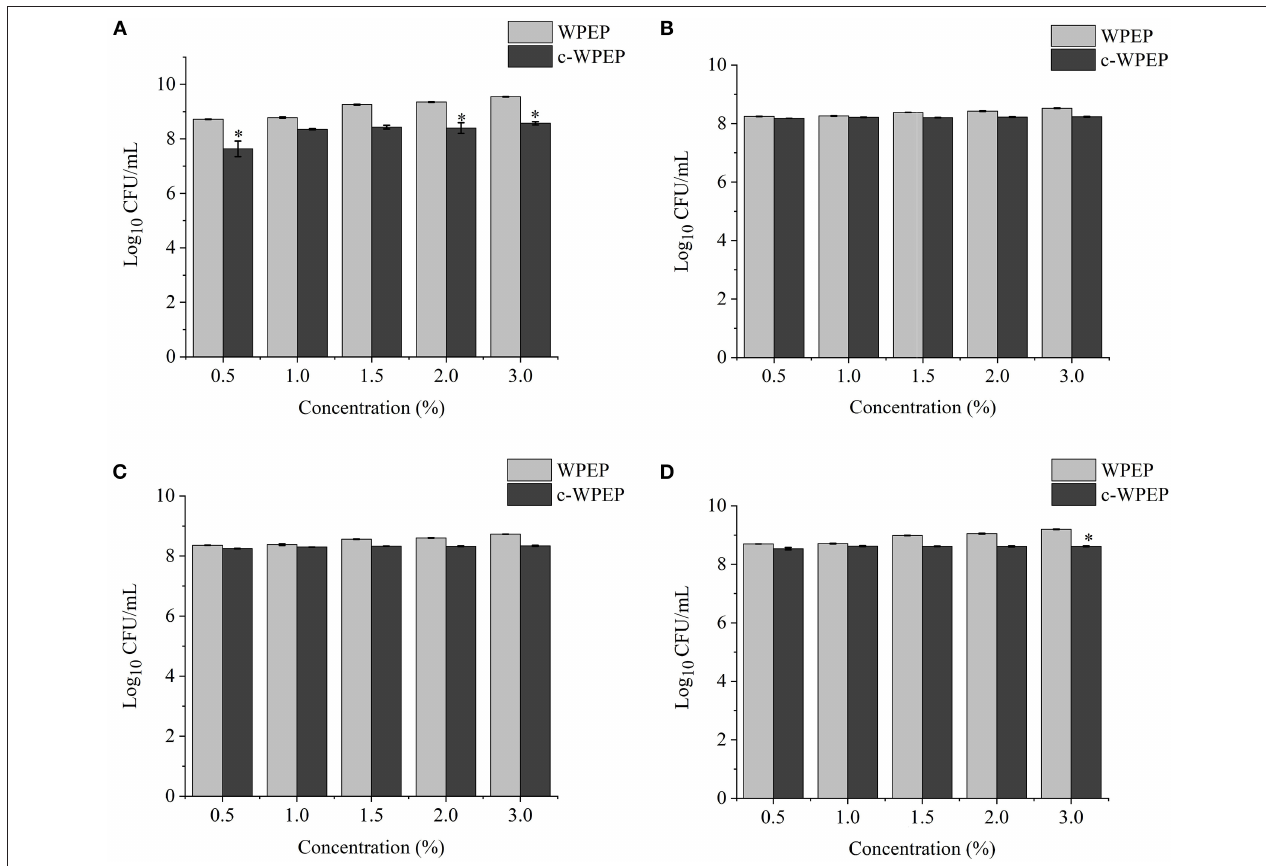
FIGURE 5 | Effects of different concentrations of the carboxymethylated crude water-soluble polysaccharides of Passiflora edulis peel (c-WPEP) sample on the growth of (A) L. brevis , (B) L. plantarum , (C) L. delbrueckii subsp. bulgaricus , and (D) S. thermophilus . * P <